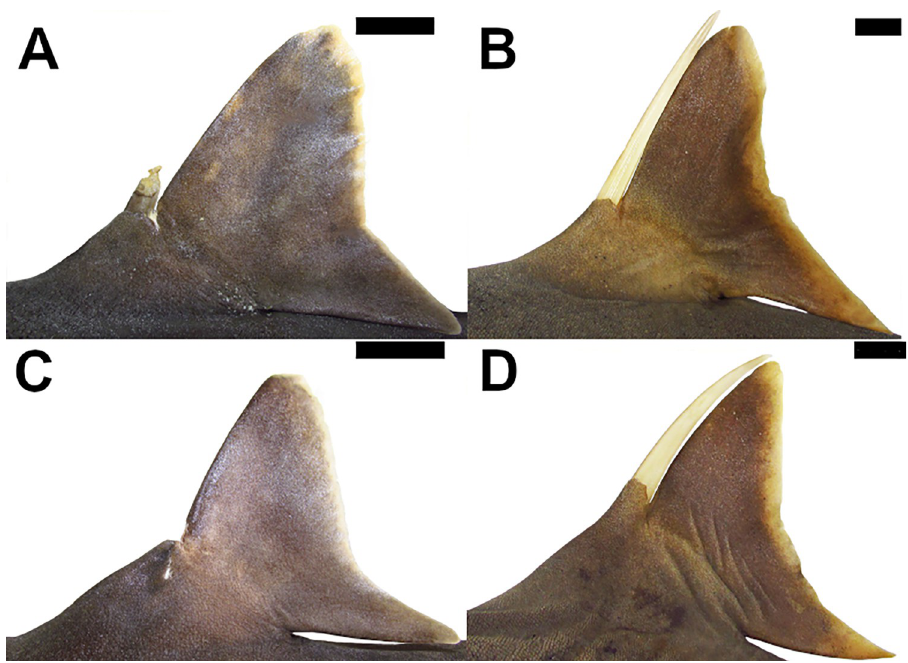
Fig 18. First (a, b) and second (c, d) dorsal fins of C . barbifer , showing intraspecific regional variations. a,c: HUMZ 197852 (neotype), adult female, 870 mm TL, Japan; b,d: CSIRO H5875-09, adult female, 978 mm TL, Indonesia. Scale bars: 20